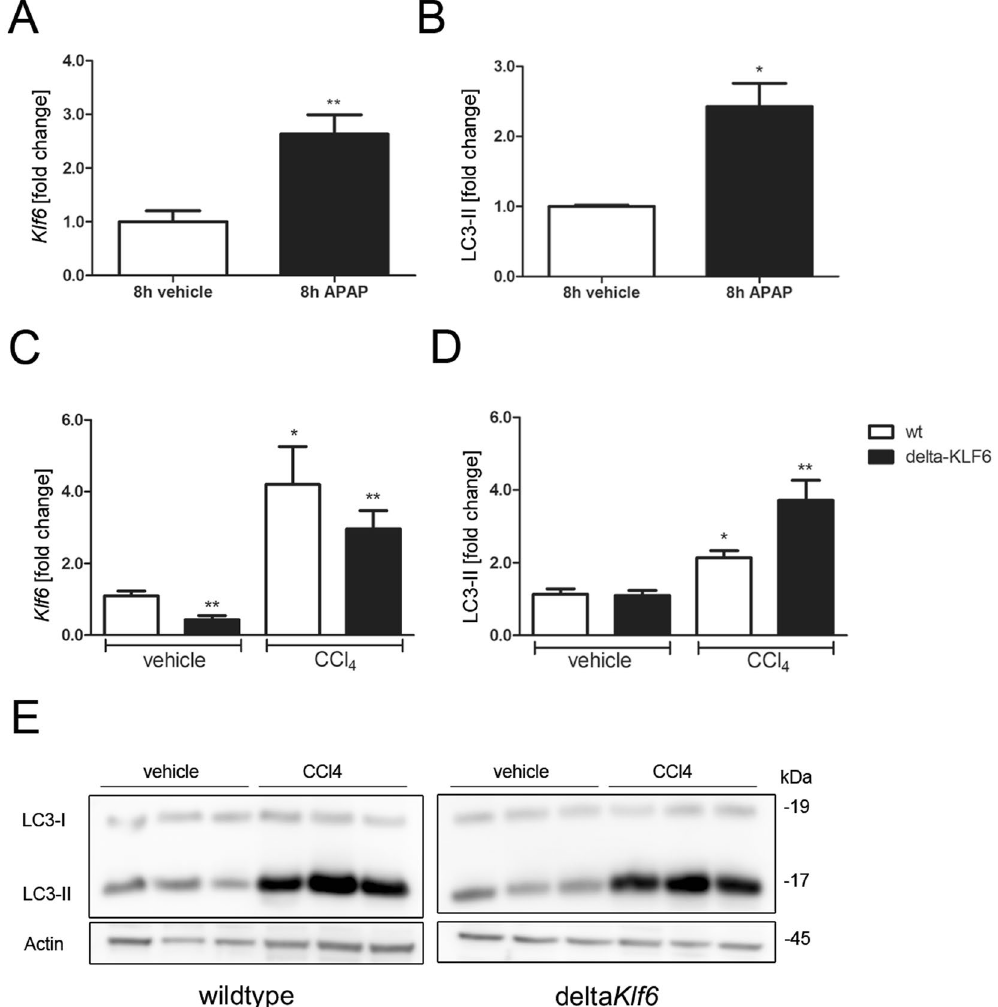
Figure 3. KLF6 is induced in different experimental models of acute hepatocellular injury. Klf6 -expression levels were quantified by qRT-PCR in liver tissue of mice that received vehicle or APAP-injection ( A ; 500 mg/ kg bodyweight after 8 h, n = 6) and in mice that received a single dose of CCl 4 ( C ; 2 µ l/g bodyweight, n = 4 for vehicle control and n = 5 for CCl 4 treated animals). Autophagy was assessed by LC3 Western blotting and quantified by densitometry of specific protein bands in liver tissue of wildtype mice following APAP-injection ( B ; Western blot images of APAP-treated mice are show in Supplementary Figure S3) or in wildtype and delta Klf 6 animals after CCl 4 injection ( D , E ). Shown are representative Western blot images of CCl 4 treated animals ( E ; full length Western blot images are given in Supplementary information) and densitometric quantification of LC3-II bands normalized to loading control Actin ( E ); fold change versus control shown as mean ± SEM of n = 4–6